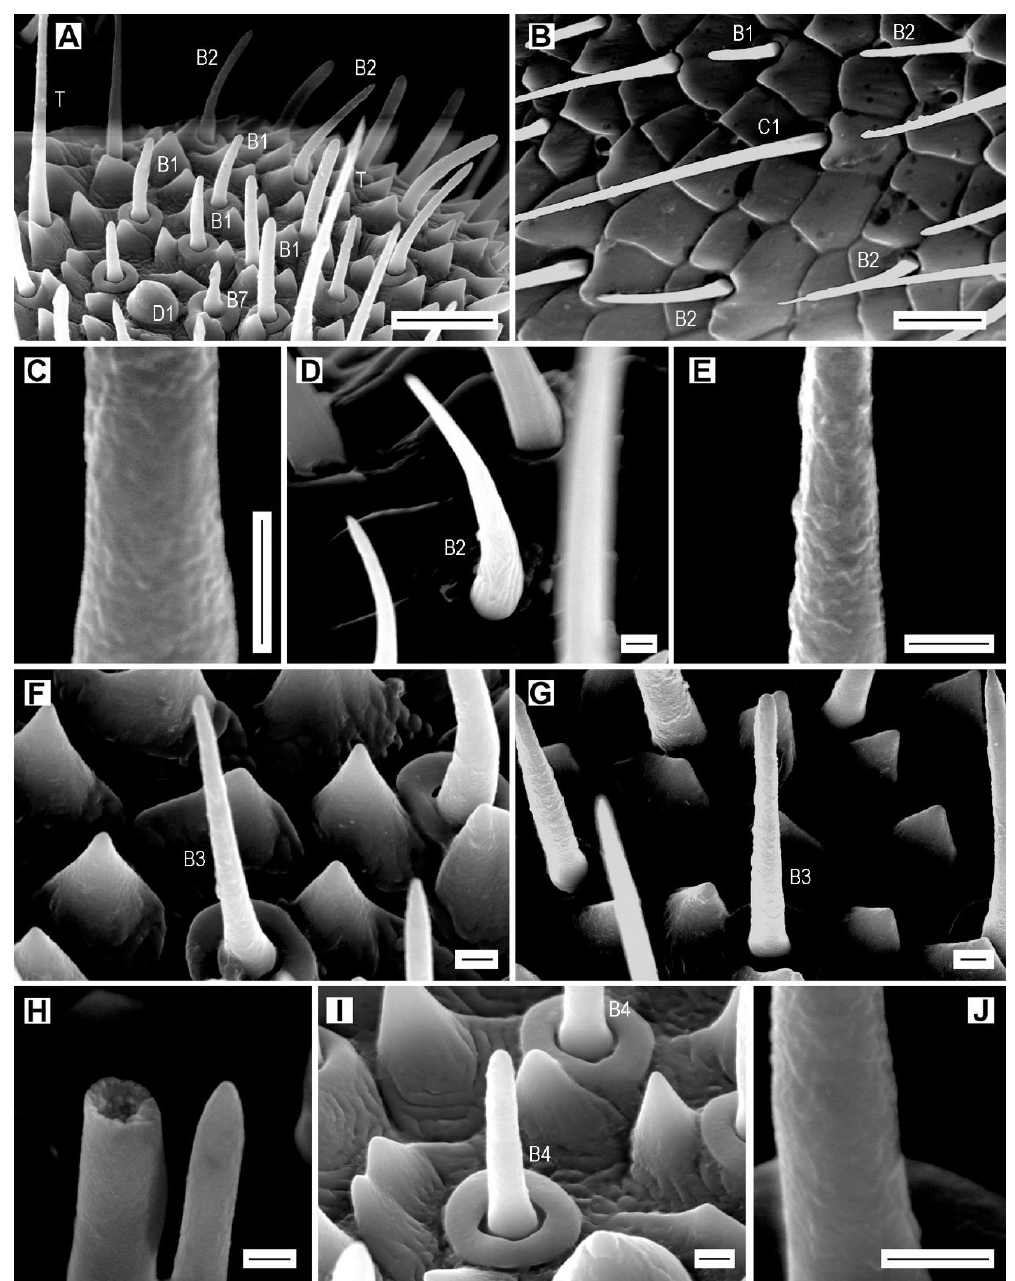
Figure 6. Sensilla basiconica of subtypes B1–B4. ( A ) A. acuminatus , male, dome-shaped sensillum D1, sensilla trichodea (T) and sensilla basiconica B1, B2, and B7; ( B ) A. acuminatus , female, sensilla basiconica B1 and B2, and sensilla chaetica C1; ( C ) A. acuminatus , male, wall pores of sensillum B1; ( D ) A. medvedevi , male, sensillum basiconicum B2; ( E ) A. acuminatus , male, detail of the wall of sensillum B2; ( F ) A. acuminatus , male, sensillum basiconicum B3; ( G ) A. acuminatus , male, sensillum basiconicum B3; ( H ) A. pilosellus , female, sensilla basiconica B3, left: broken, right: apical part; ( I ) A. acuminatus , male, sensilla basiconica B4; ( J ) A. acuminatus , male, detail of the wall of sensillum B4. Scale bars = ( A , B ): 10 μm; ( C–J ): 1 μm.